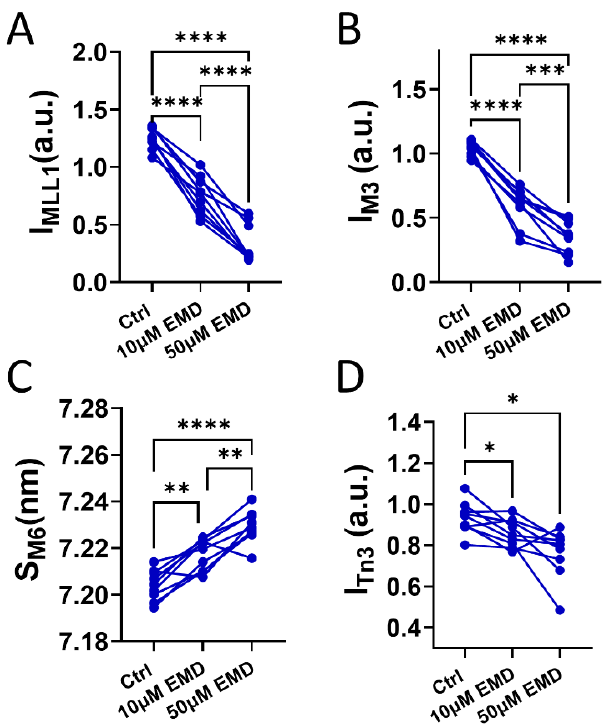
Figure 4. Effects of EMD on the myosin layer lines and the meridional reflections on the permeabilized pig myocardium. ( A ) Intensity of the first order myosin-based layer lines (I MLL1 ) from the permeabilized resting pig myocardium in the absence and presence of 10 μ M and 50 μ M EMD. ( B ) Intensity of the third order myosin meridional reflections (I M3 ) in the absence and presence of 10 μ M and 50 μ M EMD. ( C ) Spacing of the sixth order myosin meridional (S M6 ) in the presence and absence of 10 μ M and 50 μ M EMD. ( D ) Intensity of the third order troponin meridional reflections (I Tn3 ) in the presence and absence of 10 μ M and 50 μ M EMD. * p < 0.05 , ** p < 0.01, *** p < 0.001, **** p < 0.0001.